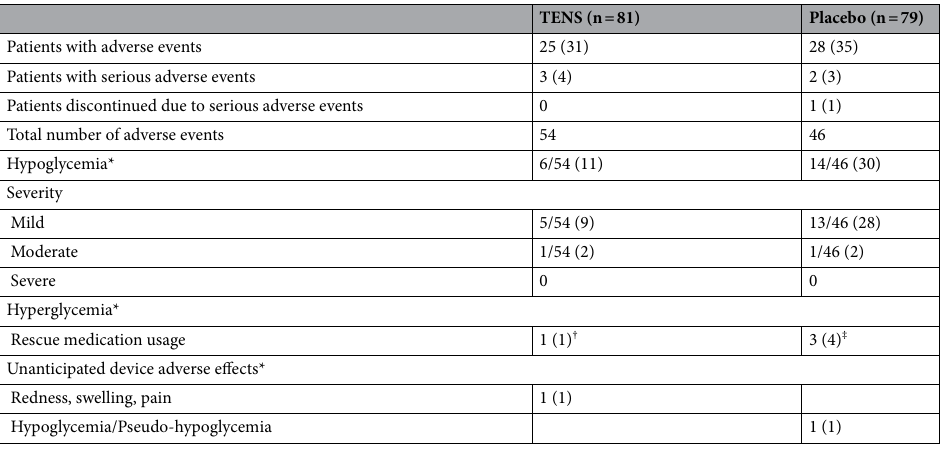
Table 3. Adverse events, serious adverse events, and unanticipated adverse device effects. See Supplementary Table S15 for a full listing of adverse events. Data are presented as n (%). *The number of hypoglycemic events, hyperglycemic events or unanticipated adverse device effects/total adverse events is presented; the percentage of hypoglycemic events, hyperglycemic events or unanticipated adverse device effects/total adverse events is shown in parentheses. † Add-on OAD was the rescue medication in this patient. ‡ insulin injections were the rescue medications in these